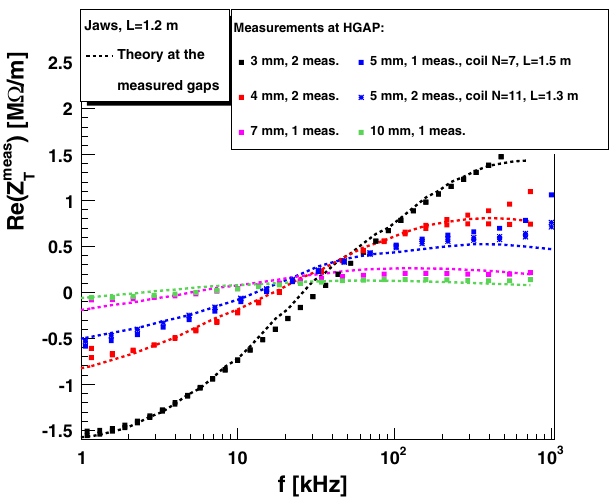
FIG. 15. (Color) Real part of Z meas , defined in Eq. (38), as T measured with stand-alone jaws (stages 2 and 3 in Table I) at different gaps and compared to the correspondent theoretical values. Measurements for half gap of 4 mm have been taken with two coils differing in length L and number of windings N . The Þ > negative values for f < 20 kHz follow from Re ð Z ref FIG. 16. (Color) (a) Real and (b) imaginary transverse imped- W Re ð Z DUT Þ at low frequencies, as discussed when defining ance of graphite jaws and CFC collimator assembly (stages 2 and W Eq. (39). 3 in Table I).